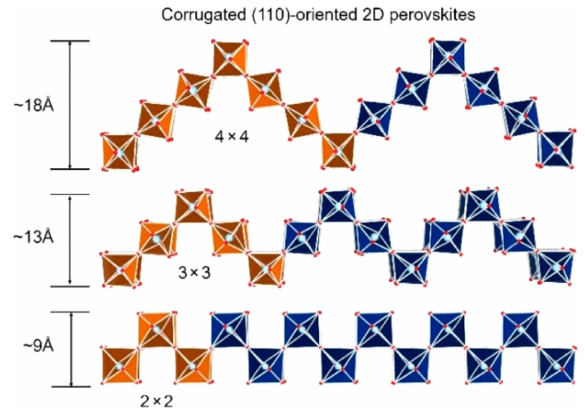
Figure 8: Schematic representation of different structural types of corrugated (110)-oriented members of the 2D perovskite family. Reprinted from Ref. [104] with permission from the American Chemical Society.